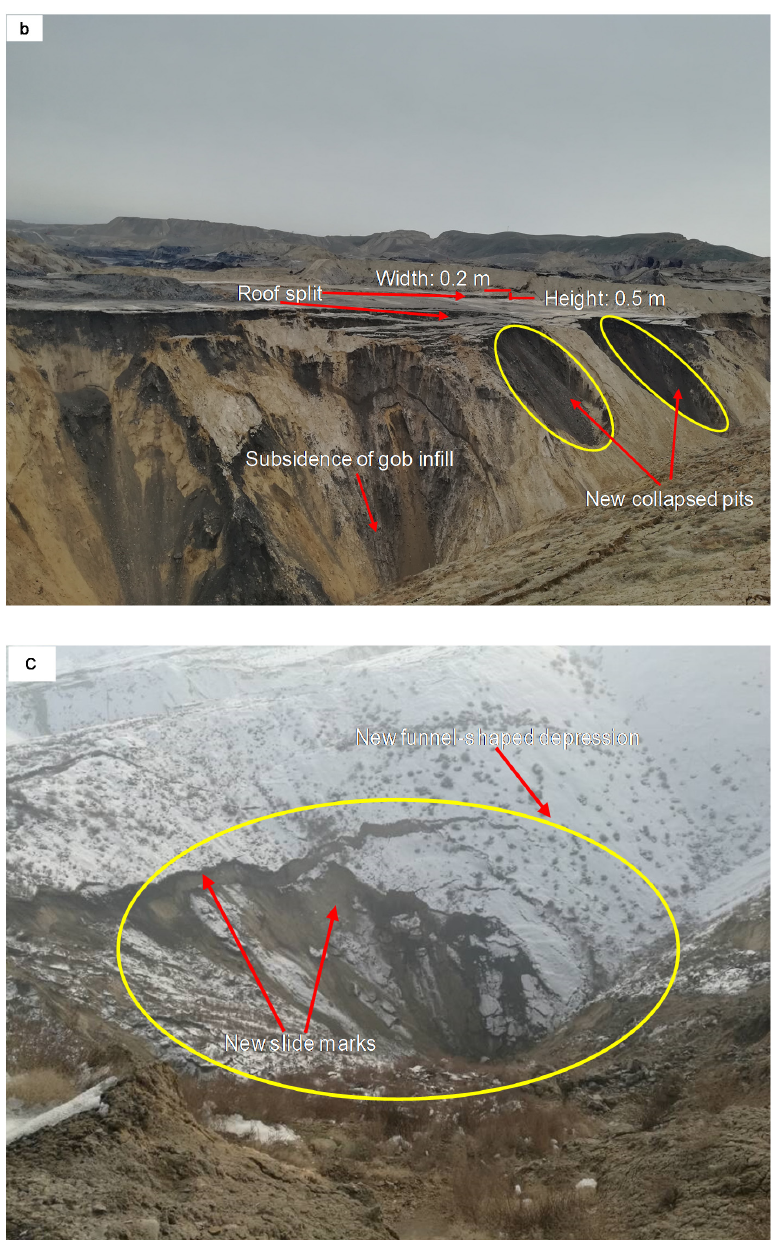
Figure 10. Ground destruction of the coal seam: ( a ) large open fracture of the roof; ( b ) roof split and subsidence of gob infill; ( c ) subsidence of gob infill after rockburst